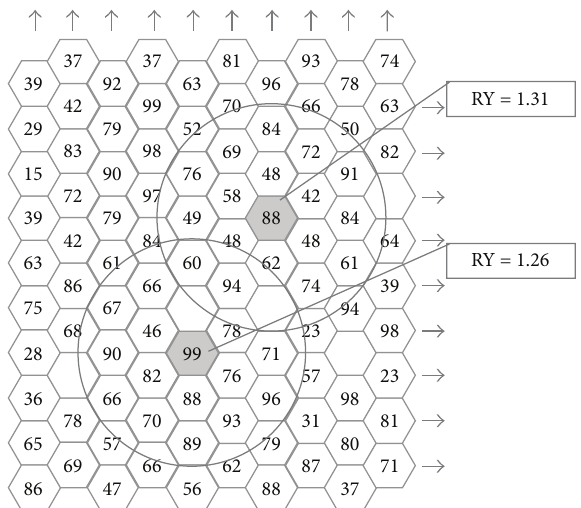
Figure 1: Single-plant qualification within a population allocated according to the honeycomb pattern [10]. Value of each plant is measured through its relative yield ( 𝑥/𝑥 𝑟 ); that is, absolute yield ( 𝑥 ) of the central plant is divided by the mean yield ( 𝑥 𝑟 ) of all the plants included in the circle of a chosen size (up to 19 plants in this hypothetical example, missing plants do not exert any effect on the condition they are positioned widely enough to exclude interplant competition). The upper central plant is granted on relative yield better than the lower central plant (1.31 versus 1.26), even though worse on absolute yield (88 versus